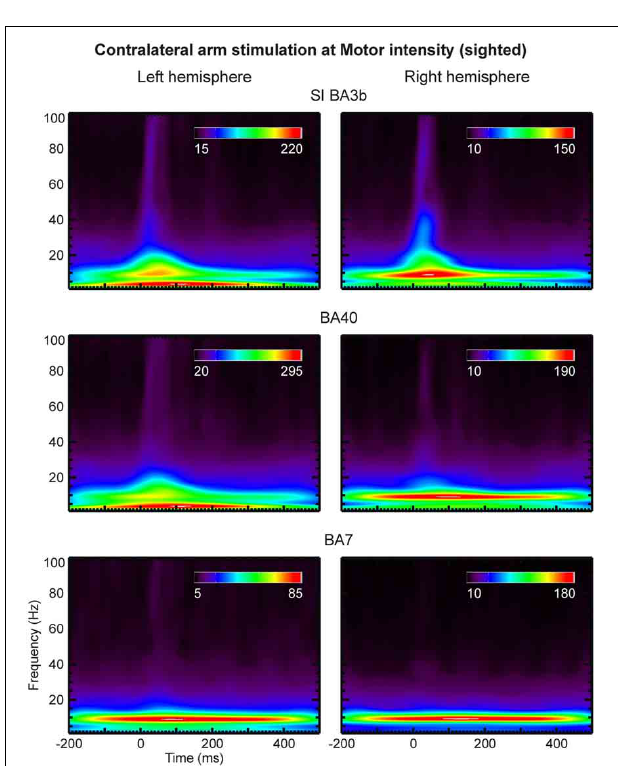
FIGURE 8 | Scalograms of three left (left column) and right (right column) hemisphere ROIs (indicated on top of each row) are shown for contralateral arm stimulation at Motor threshold in a sighted subject. The coefficient values are given in arbitrary units.